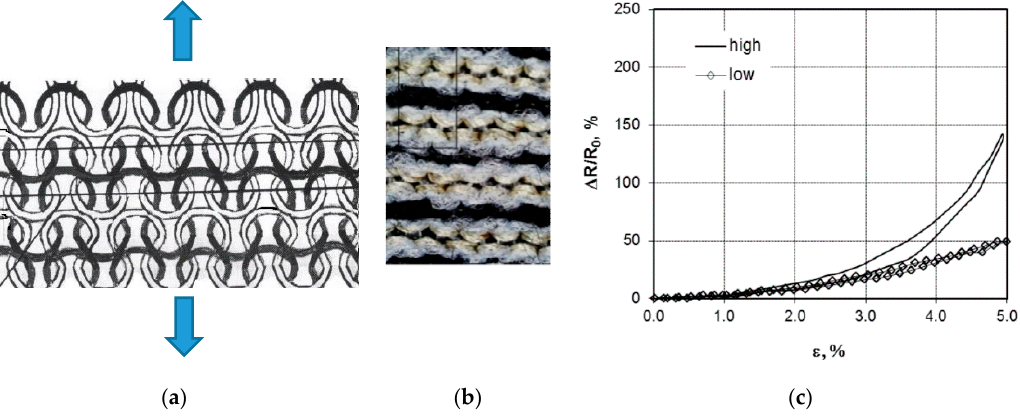
Figure 13. ( a , b ) Alternating courses of conductive and non-conductive yarns; ( c ) resistance change [64] .